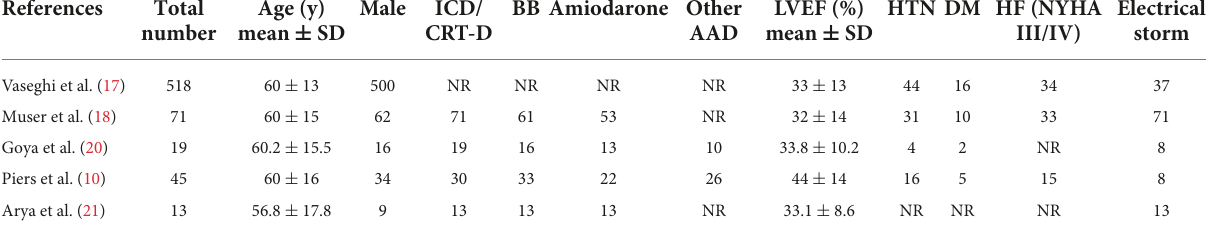
TABLE 2 Baseline clinical